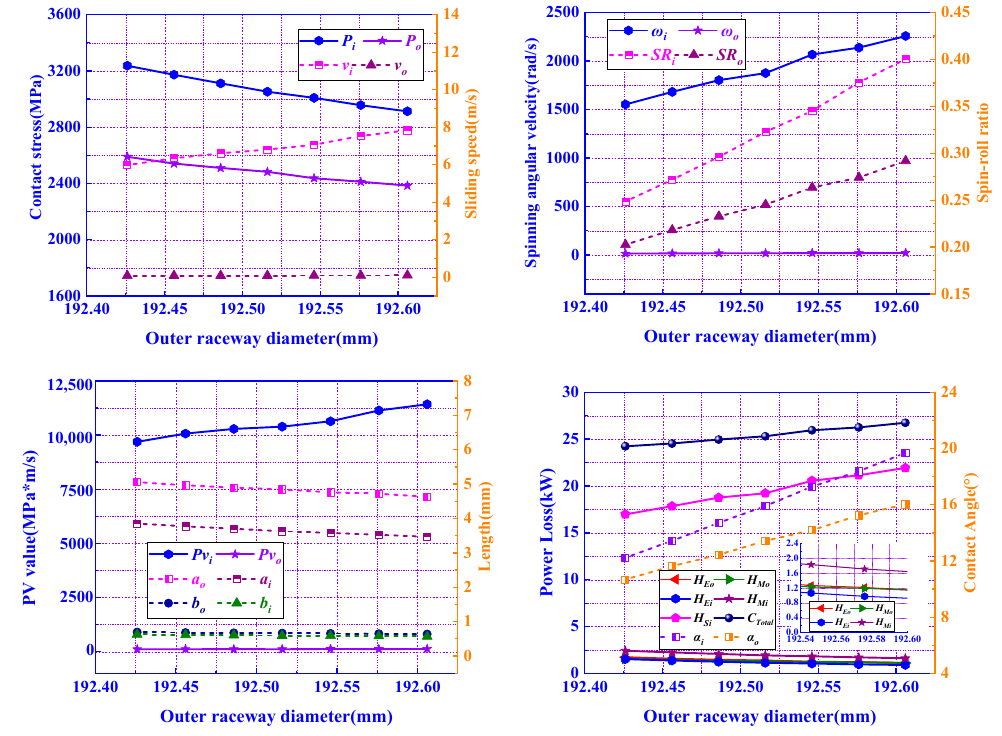
Figure 14. Influence of outer raceway diameter D e on the power loss. 3.2.2. Influence of Inner Raceway Diameter d i on Power Loss Inner raceway diameters in the range of 138.368 to 138.548 mm were studied, and the power loss, and other dynamic parameters are shown in Figure 15.